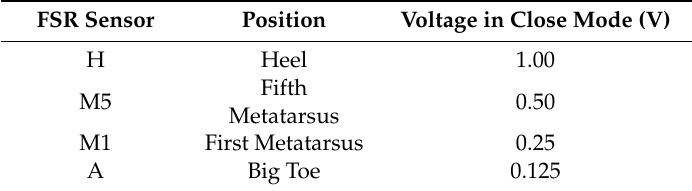
Table 1. Voltages provided by the Force-Sensitive Resistors (FSR) sensors in close mode. FSR Sensor